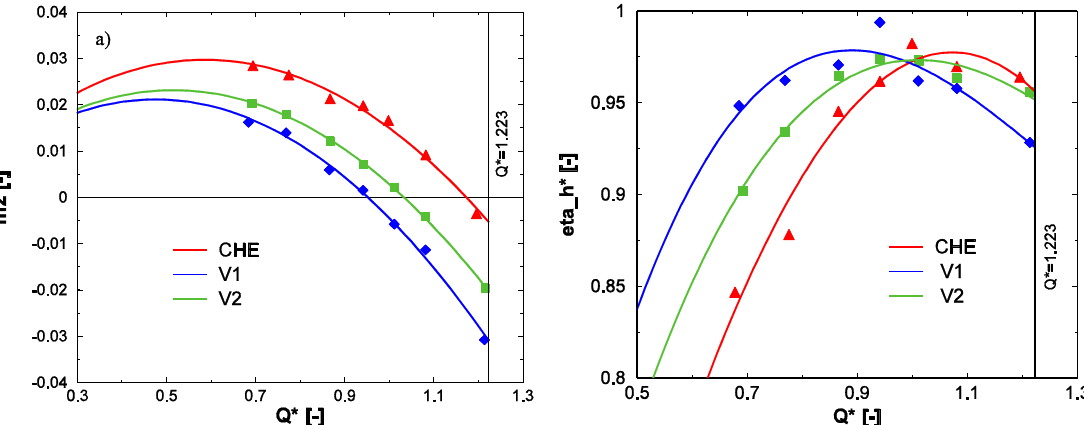
Fig. 4. (a) The dimensionless fl ux of moment of momentum ( m 2 ) versus the normalized discharge ( Q *). (b) The hydraulic ef fi ciency ∗ ( h h ) versus the normalized discharge ( Q *).